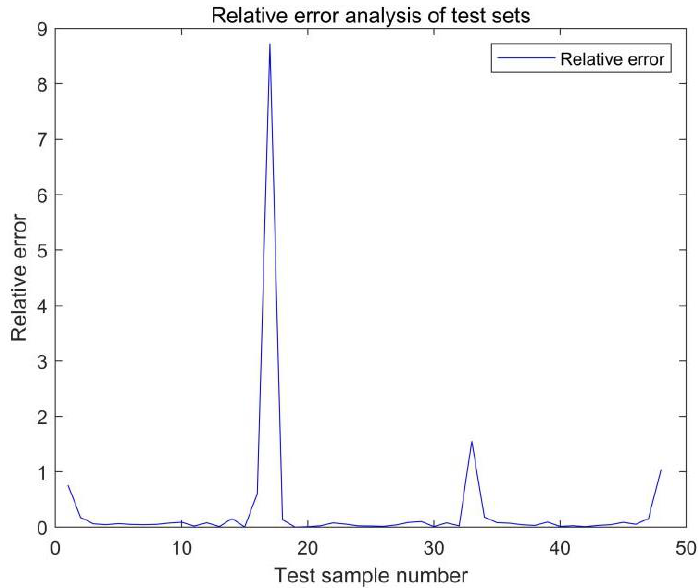
Figure 23. The relative error values of the test set.